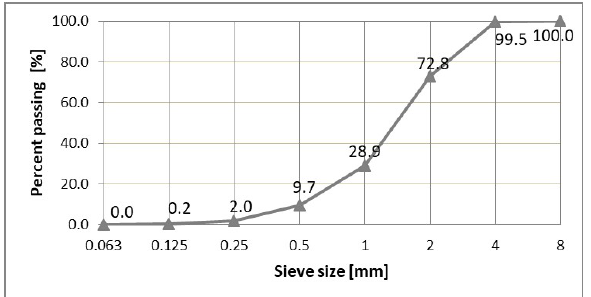
Figure 3: Grading curve of aggregate.